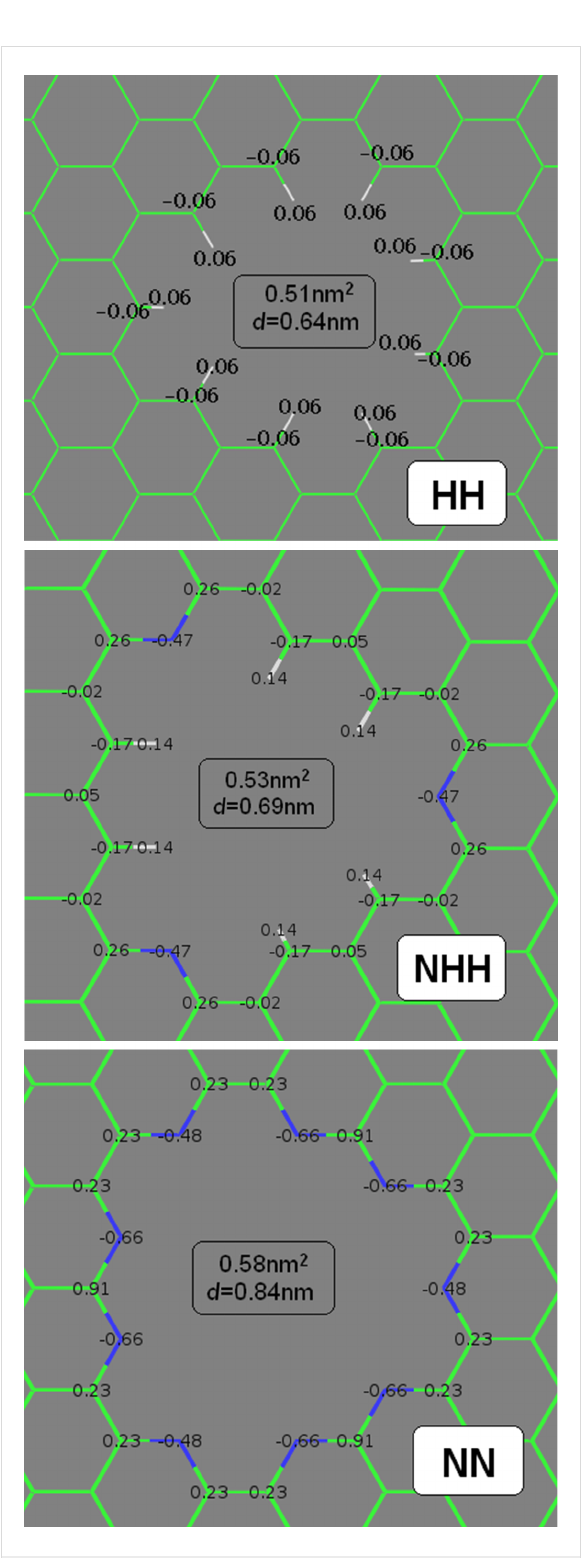
Figure 2: Atomic charges for nanopores HH (top), NHH (middle) and NN (bottom). The charges of the remaining carbon atoms in the graphene sheets were assumed to be zero. The charges of hydrogen atoms in the nanopore HH were obtained using the OPLS force field. Average pore areas and diameters are denoted in the